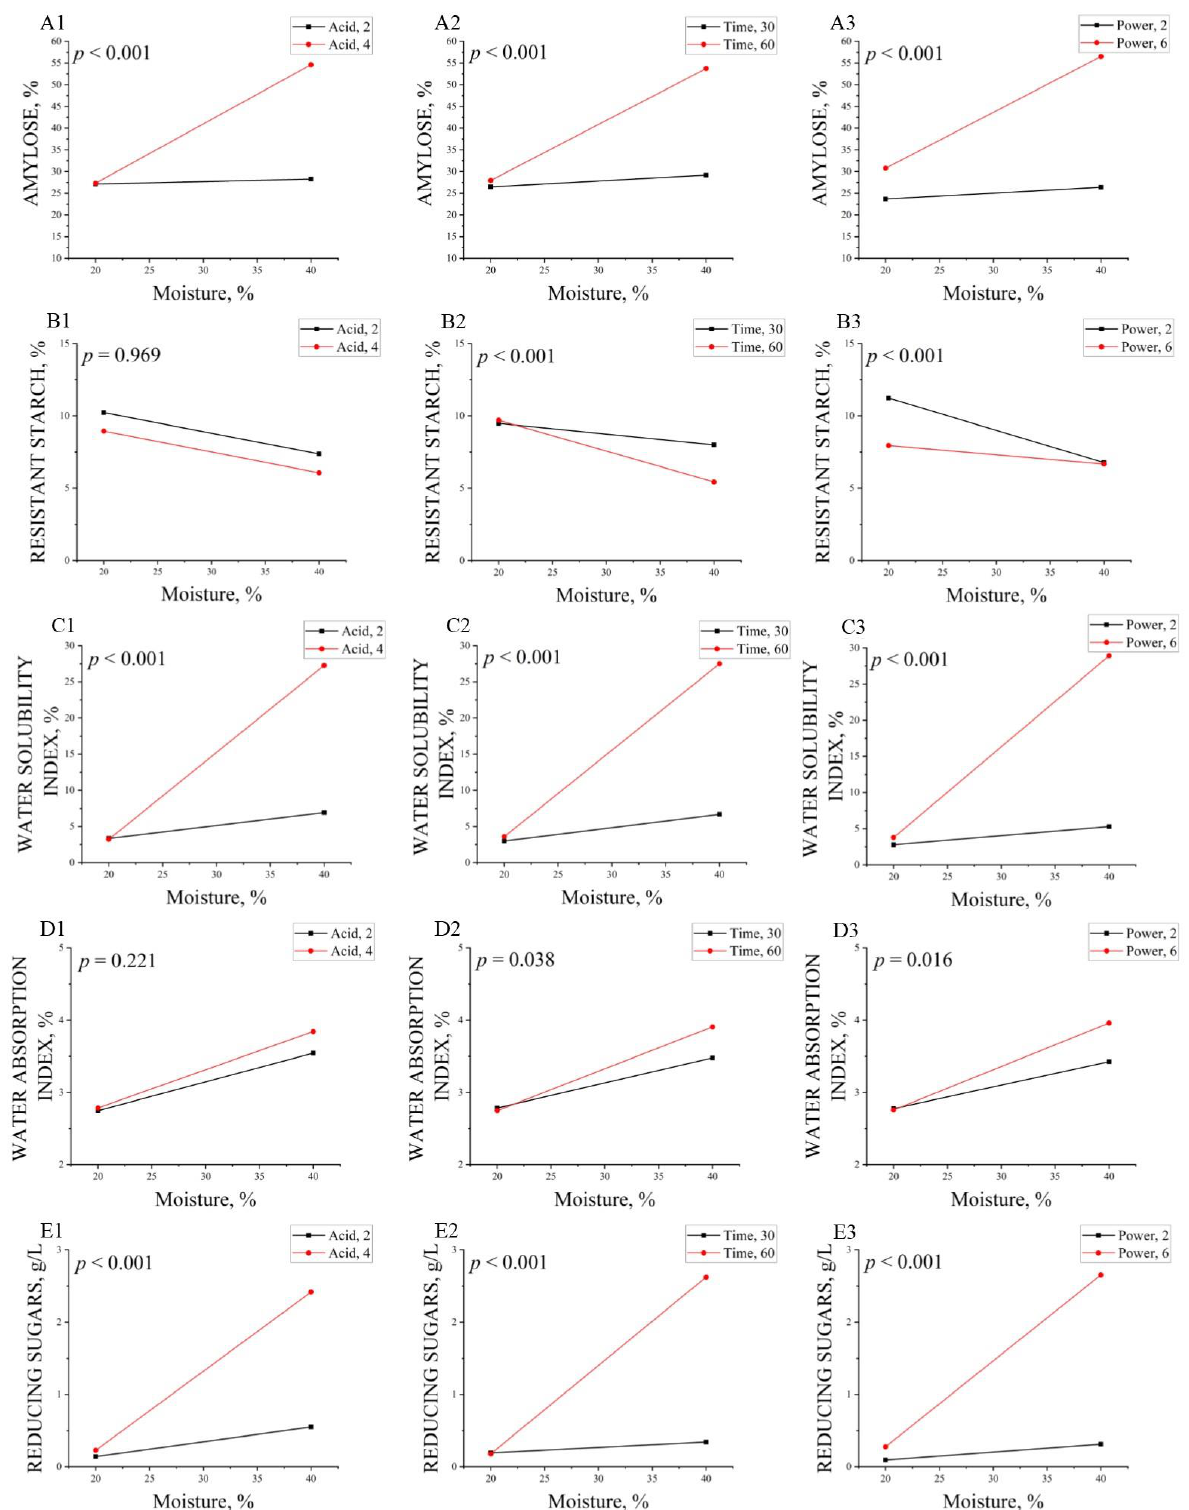
Figure 1. Interaction effects of moisture with pure hydrochloric acid, moisture with time, and moisture with power level. ( A1 – A3 ), interactions effects for amylose; ( B1 – B3 ), interactions effects for resistant starch; ( C1 – C3 ), interactions effects for water solubility index; ( D1 – D3 ), interactions effects for water absorption index; ( E1 – E3 ), interactions effects for reducing sugars.